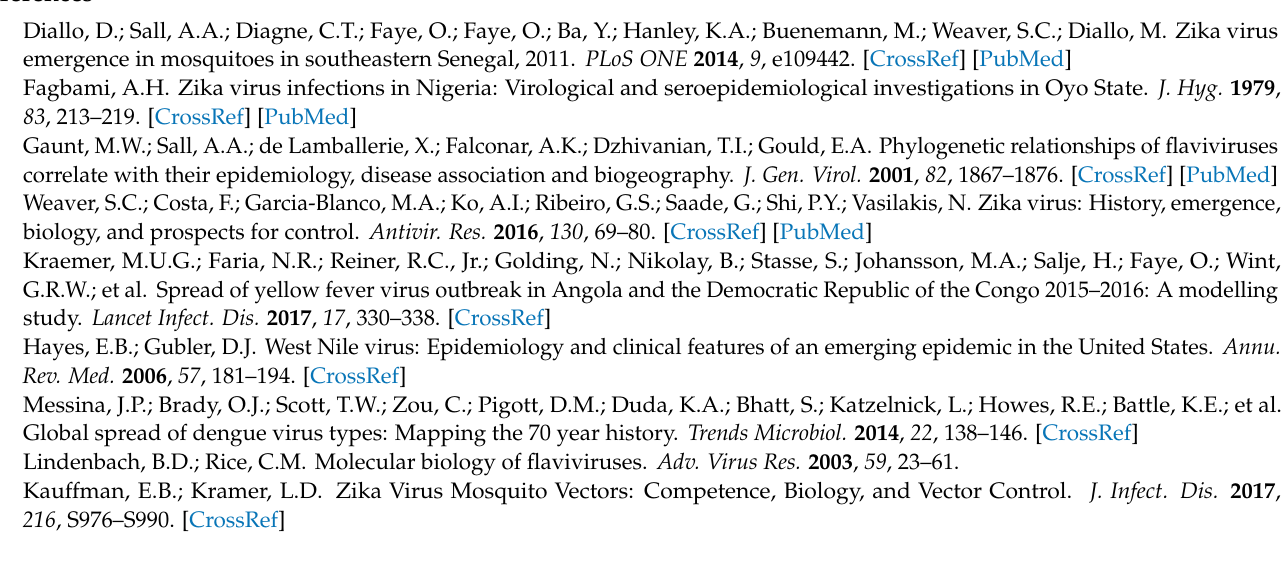
Figure S3: Negative genetic assay of flavivirus viroporins, Figure S4: Positive genetic assay of flavivirus viroporins., Figure S5: Proton flow assay of flavivirus